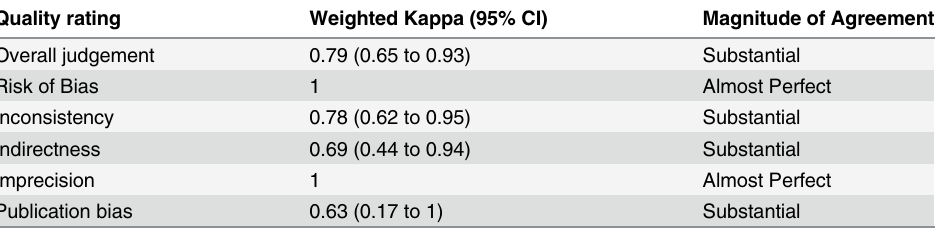
Table 1. Comparison of raters ’ judgements for two independent raters using the Semi-Automated Quality Assessment Tool